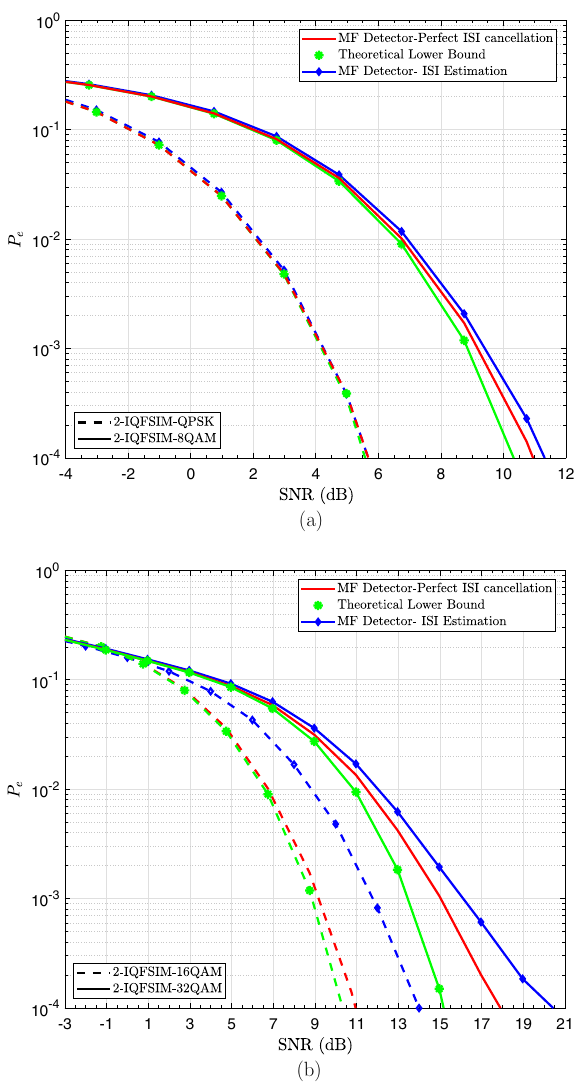
Fig. 8 Comparison of the total probabilities of filter error on I and Q using ISI-EC, perfect ISI cancellation, and the derived theoretical lower bound, N = 2 (2-IQ-FSIM- M QAM). The SE is: a [4, 5] bpcu using M = [ 4,8 ] ,